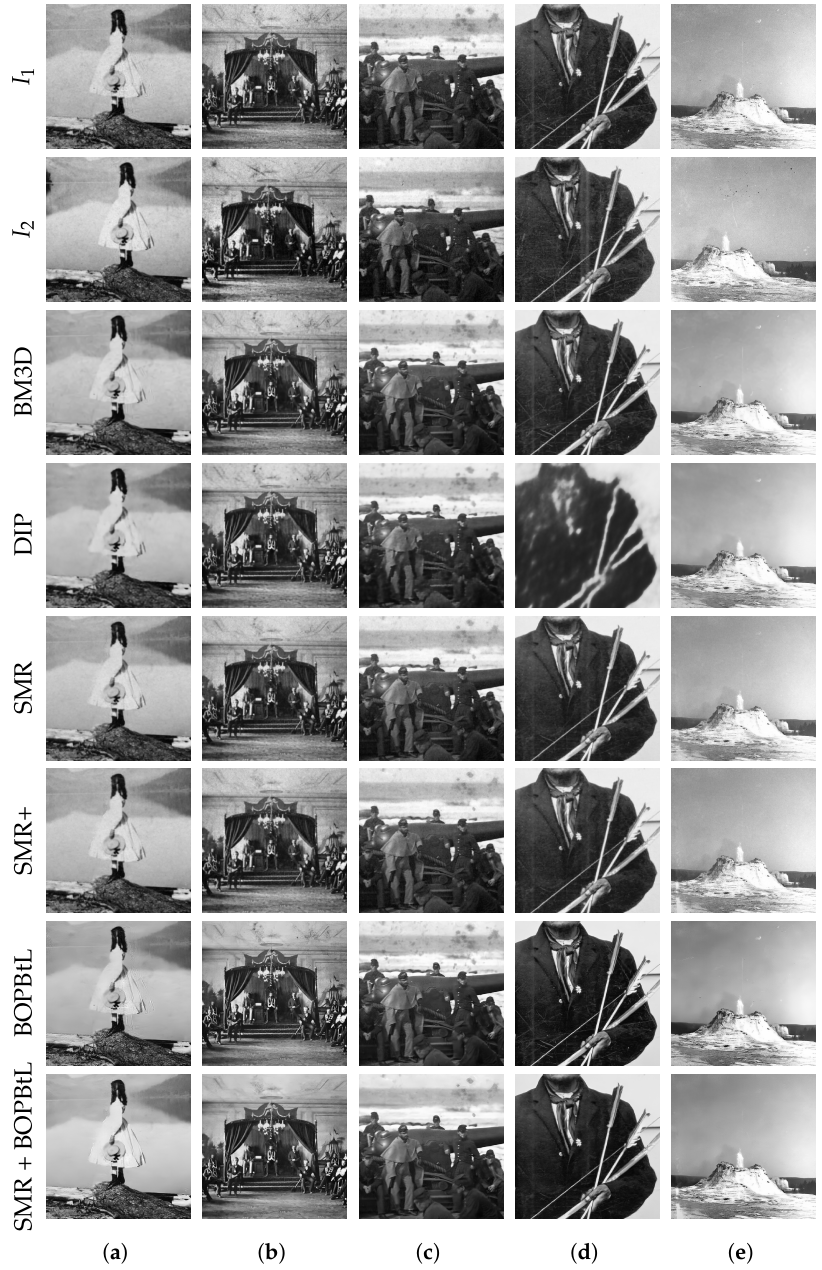
Figure 11. Qualitative visual comparison of the methods under test. Best viewed in color. The reader is invited to zoom in on the electronic version of the manuscript in order to better appreciate the